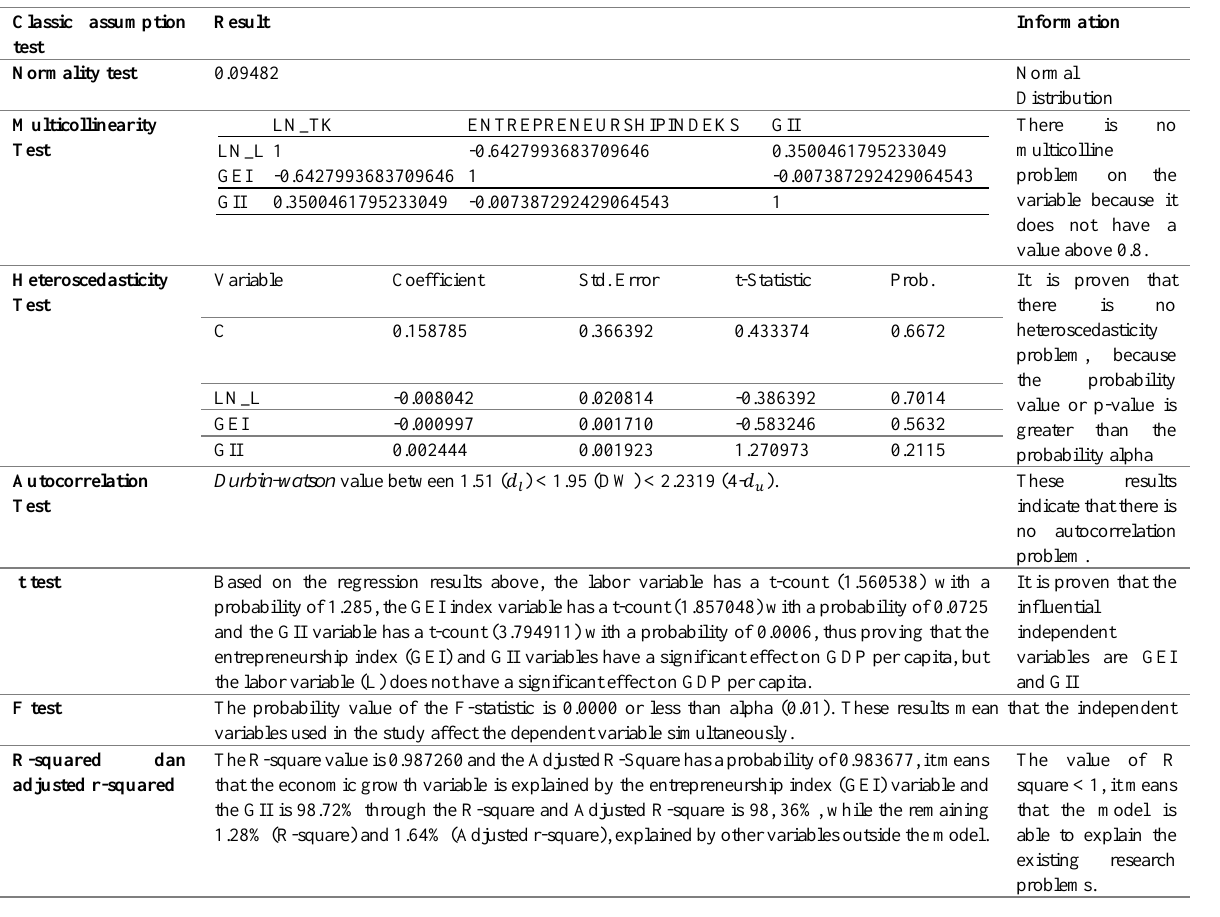
Table 4: Result of Classical Regression and Assumption